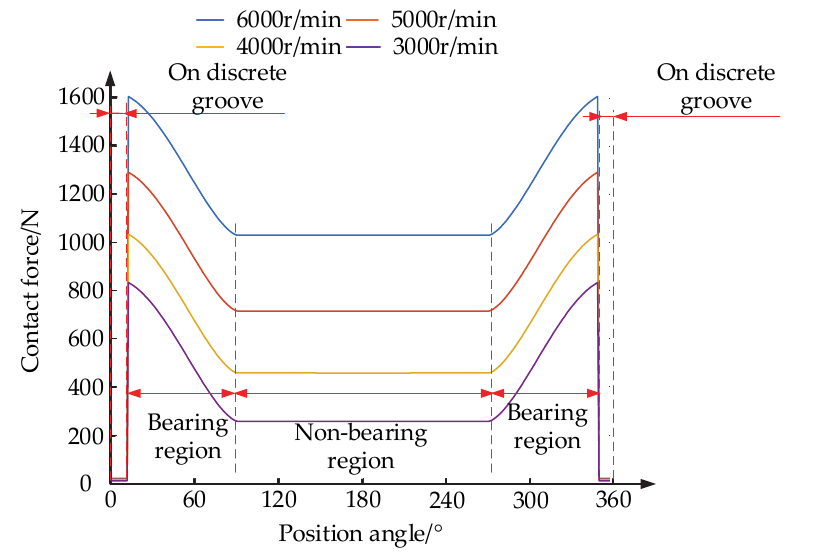
Figure 8. Variation in contact forces between the rolling element and the aggregate element at dif- ferent positions of the aggregate element.